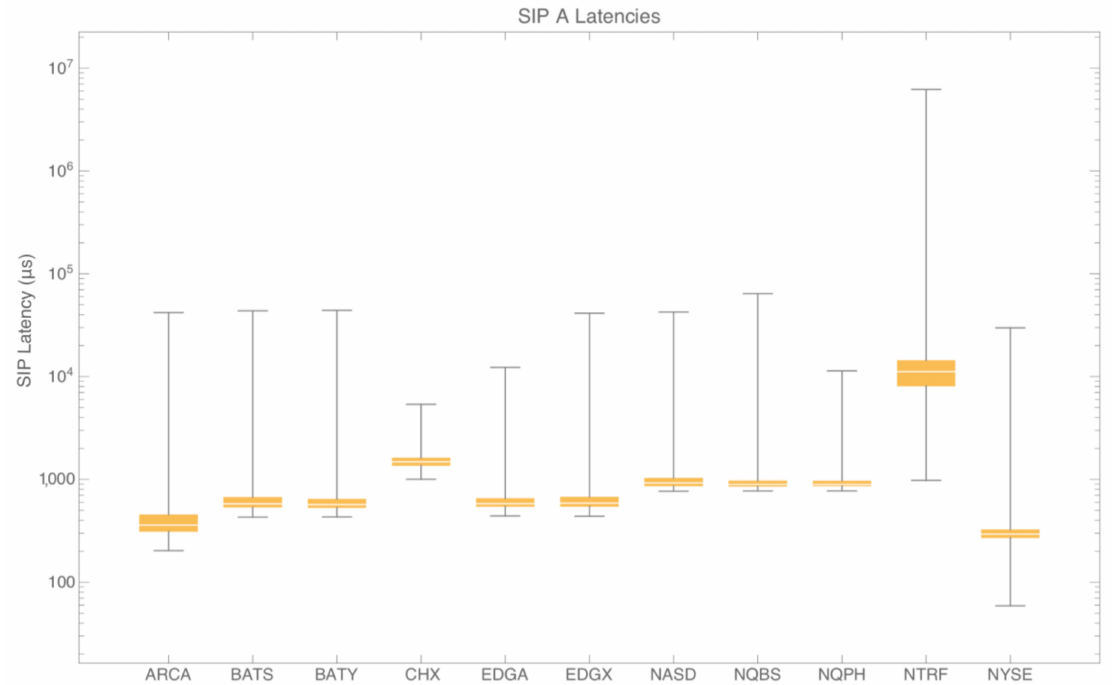
Figure 10. Box plots of latencies for all trades of all stocks traded on 11 August 2015 in microseconds reported by SIP A and separated by exchange.